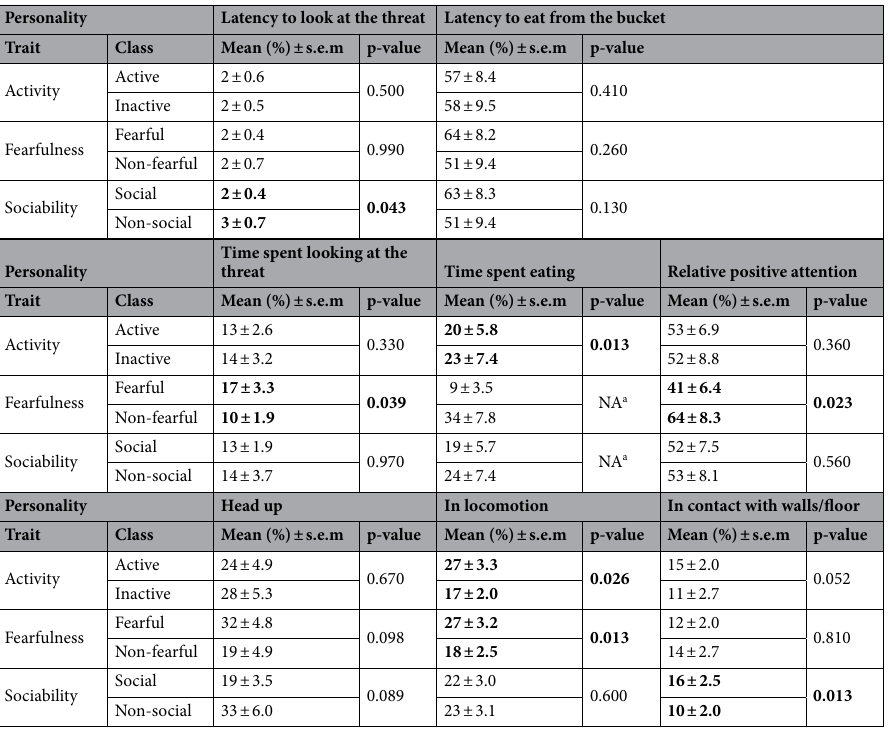
The longitu- dinal analyses of cognitive biases both in the reference and in the experimental conditions were used to assess the main effect of housing on heifers’ cognitive biases while controlling for individual variations—including personality differences. Regarding the JBT results, housing did not influence heifers’ Average latency to reach the ambiguous cues (p = 0.700, reference: 52% of total trial duration ± 5.0, positive: 54% ± 6.4, negative 59% ± 6.9). Regarding the ABT results, heifers in the negative conditions looked at the threat later and walked less than heifers in the positive conditions (p < 0.001 and p = 0.011, respectively). Furthermore, heifers in the positive,